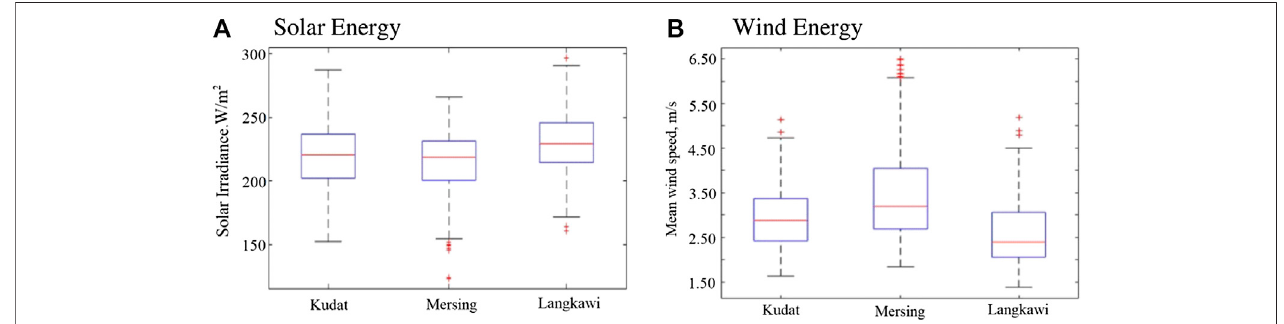
FIGURE 2 | Boxplot of monthly mean data of wind speed and solar radiation for Kudat, Langkawi, and Mersing.